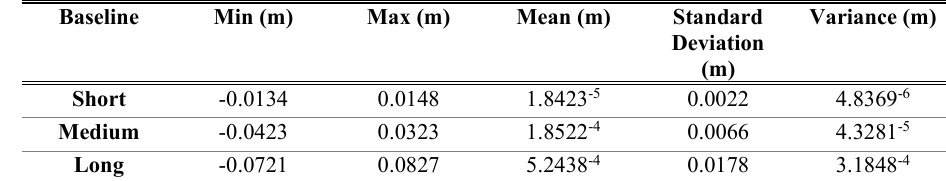
Table 2. Statistical analysis on dispersive medium of GPS distance-dependent errors.